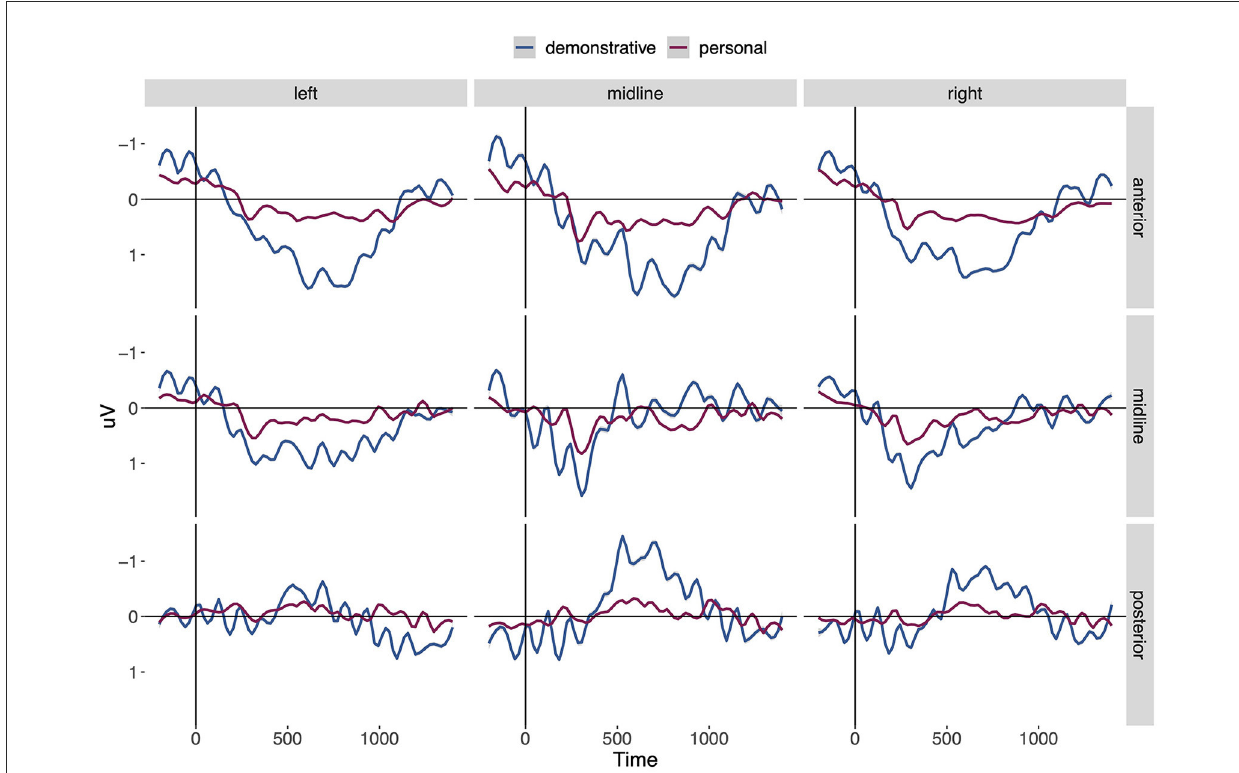
FIGURE4 Grand-average ERPs for d-pronouns (blue) and personal pronouns (red) averaged for nine regions of interest. The vertical line indicates the onset of the pronouns. Negativity is plotted up.